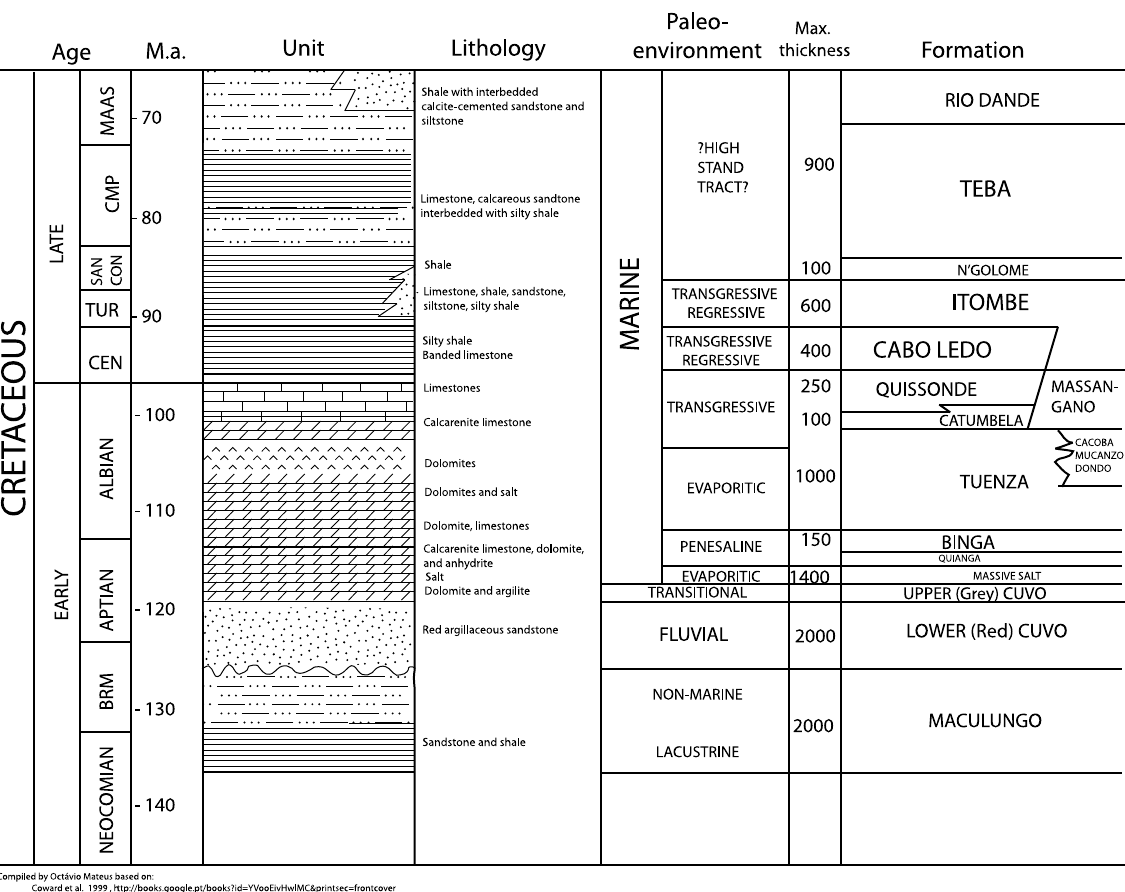
Fig. 2 – Summary of the geology of the Cretaceous of Kwanza Basin (Angola) based on Brownfield and Charpentier (2006) and Coward et al.